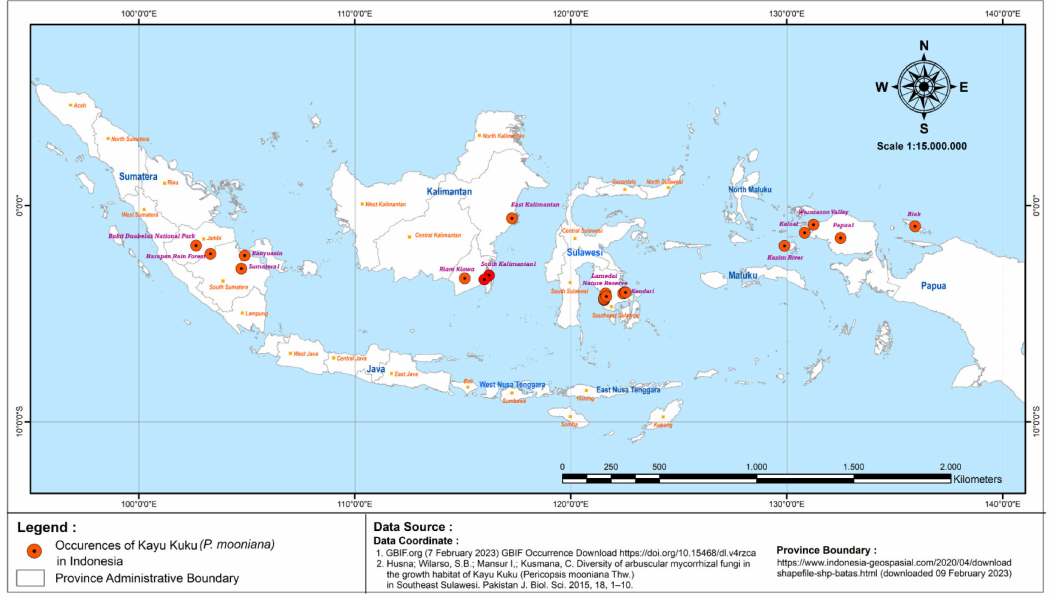
Figure 3. Distribution map of P. mooniana in